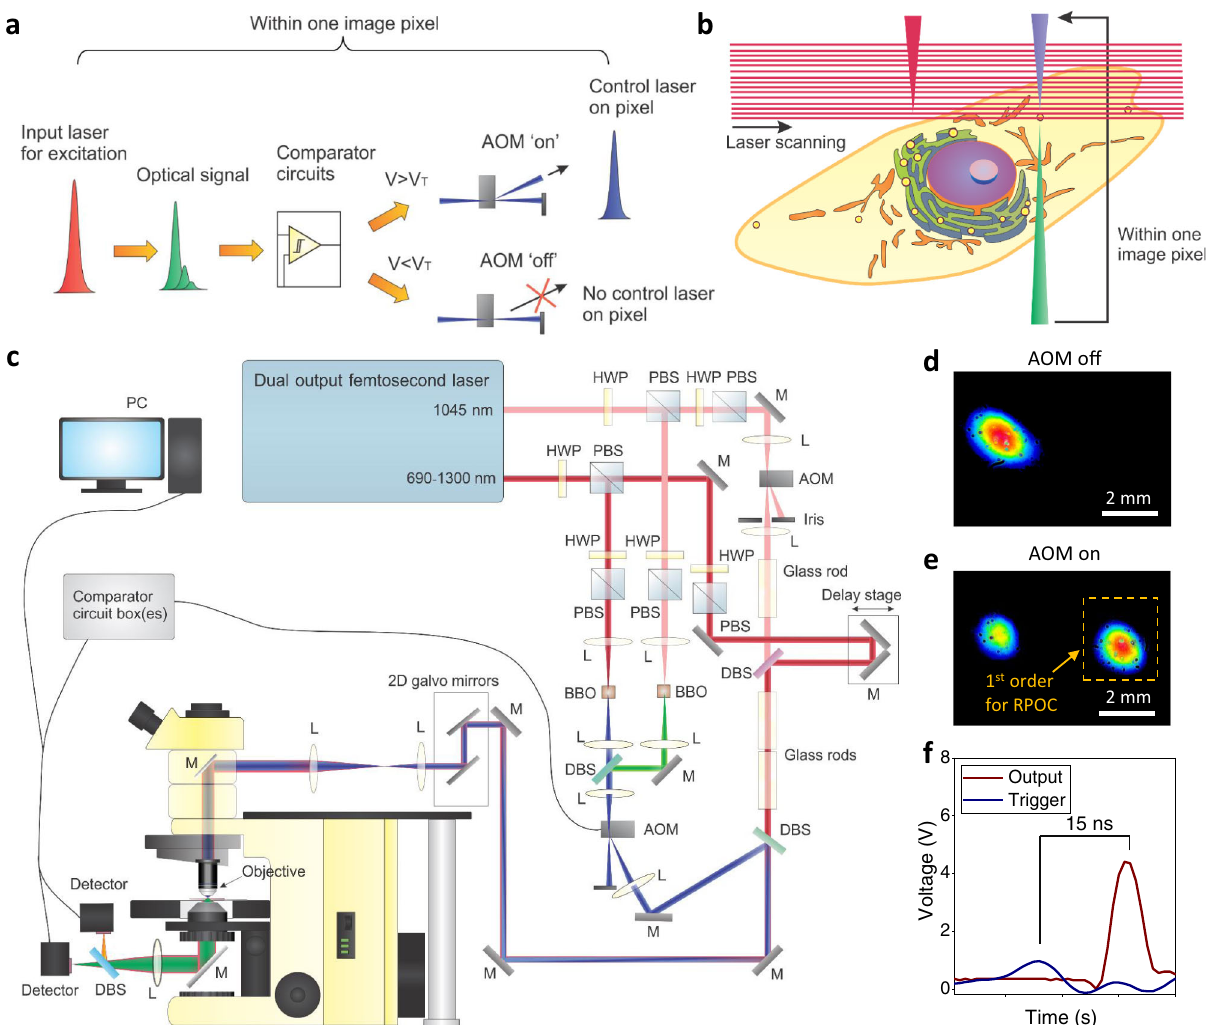
Fig.1|TheRPOCconceptandopticalcon fi guration.a AnillustrationoftheRPOC concept. b An illustration of RPOC for selective control of molecular activities in a cellduringlaserscanning. c AschematicoftheRPOCexperimentalsetup.HWPhalf- wave plate, L lens, M mirror, DBS dichroic beam splitter, PBS polarization beam splitter, AOM acousto-optic modulator, BBO Beta Barium Borate. d The pro fi le of